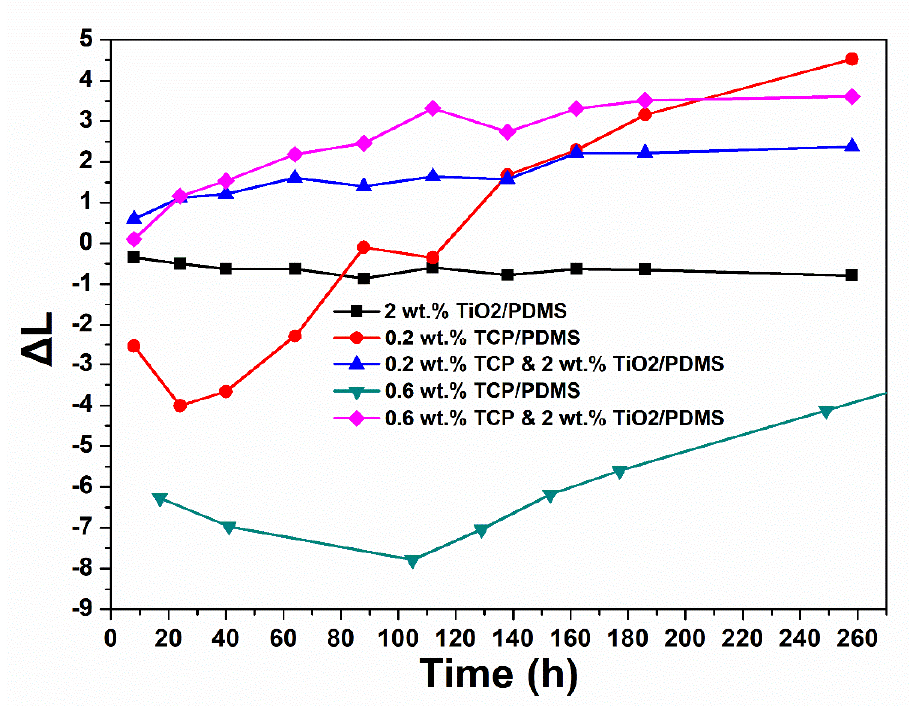
Figure 9. The light-dark character Δ L as a function of time, during accelerated aging of silicone elastomers colored with TCP (0.2 and 0.6 wt%).